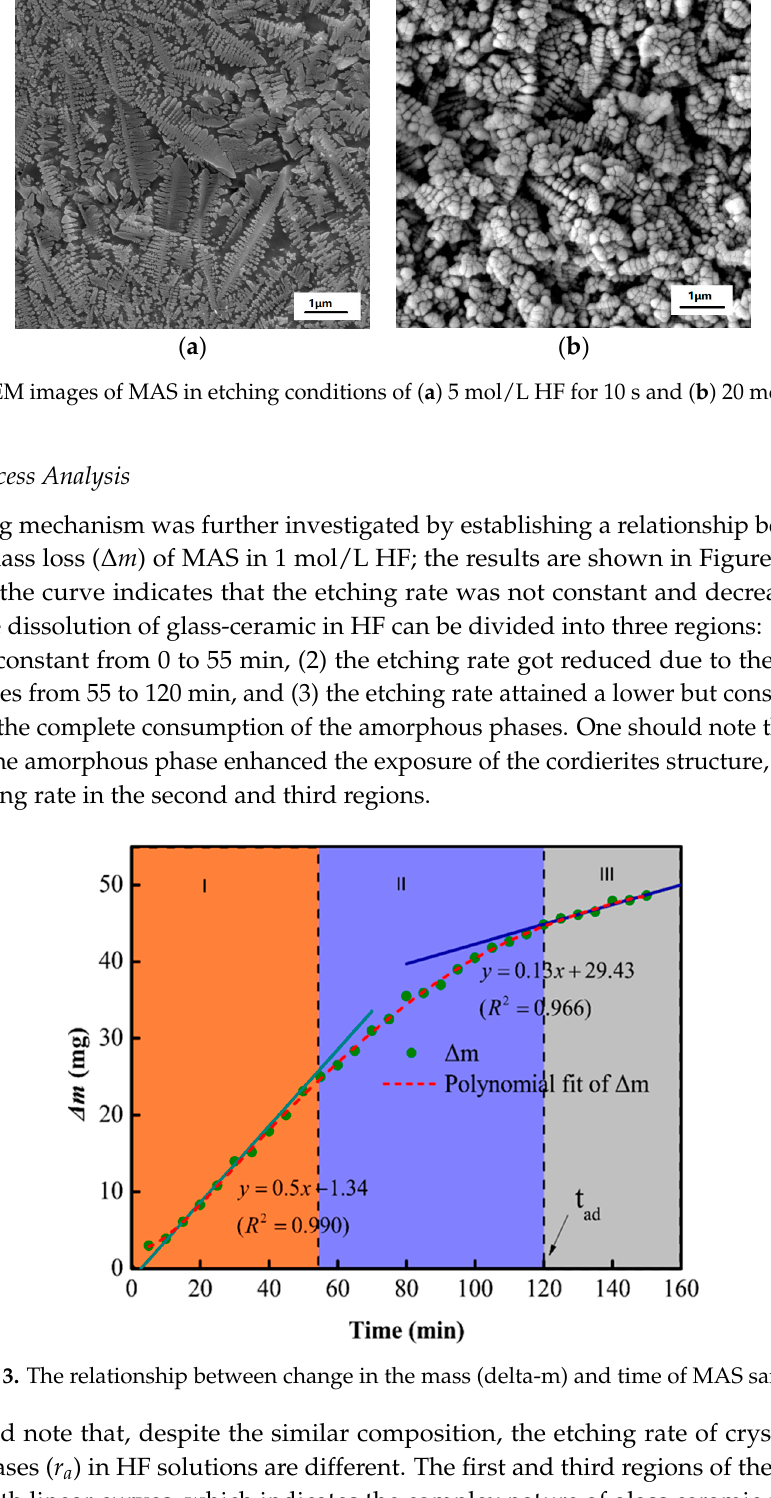
Figure 1. X-ray diffraction patterns of MAS .